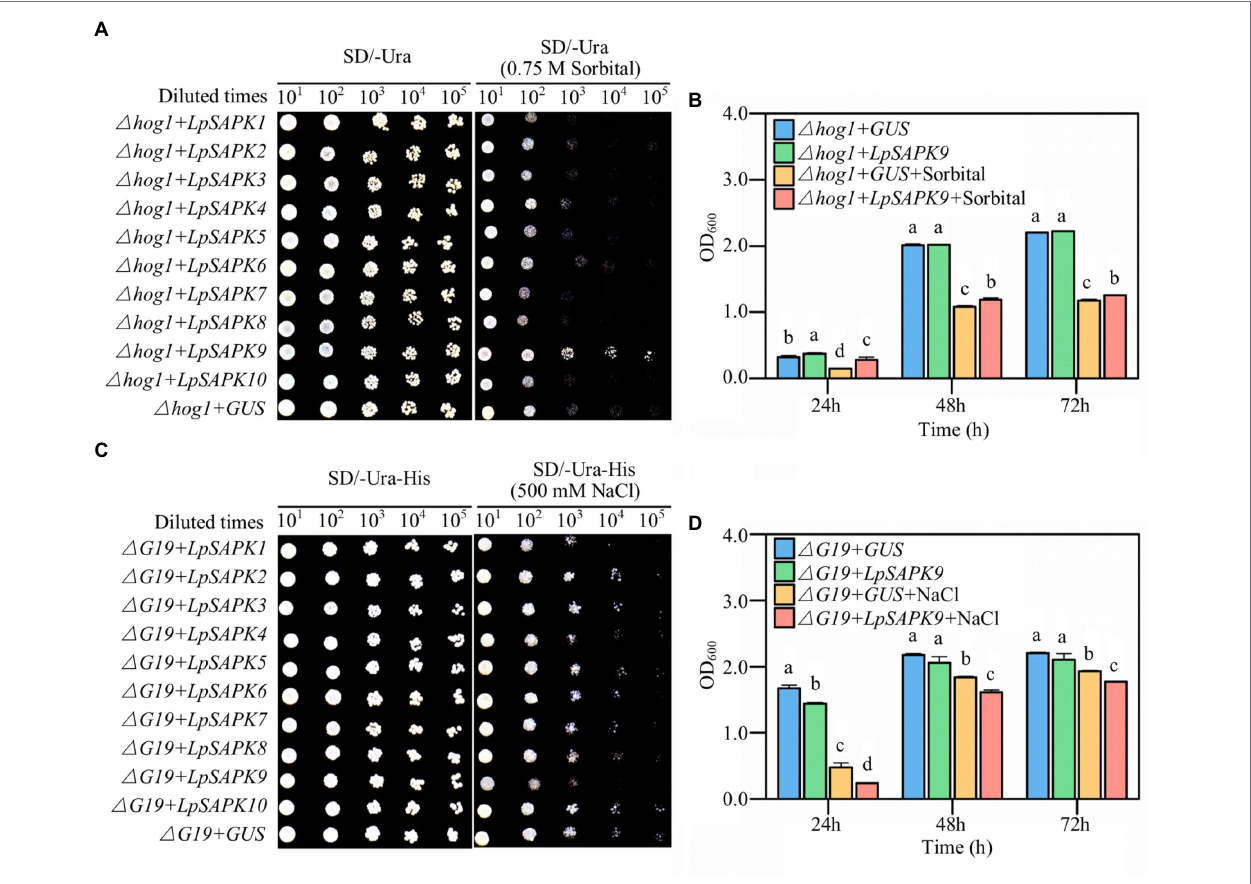
FIGURE 8 | Drought and salt tolerance assessment of yeast cells with heterologous overexpressed of LpSAPKs . (A,B) The growth of ∆ hog1 yeast mutants transformed with the GUS gene (negative control) or with all the LpSAPKs on SD-Ura medium with or without sorbitol. (C,D) The growth of ∆ G19 yeast mutants transformed with the GUS gene or with all the LpSAPKs on SD-Ura-His medium with or without NaCl. Data in b and c are means ± SE ( n = 4). Different letters above bars represent significant differences at p ≤